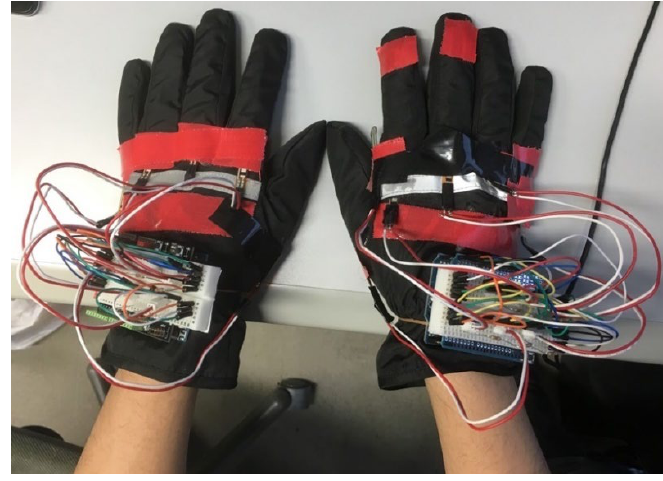
Figure 1. The Sign-Glove on